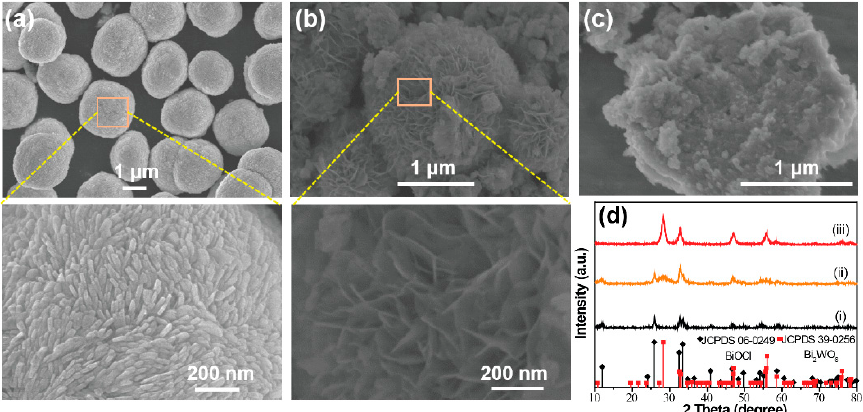
Figure 1. Field-emission scanning electron microscopy (FESEM) images of the as-prepared samples: